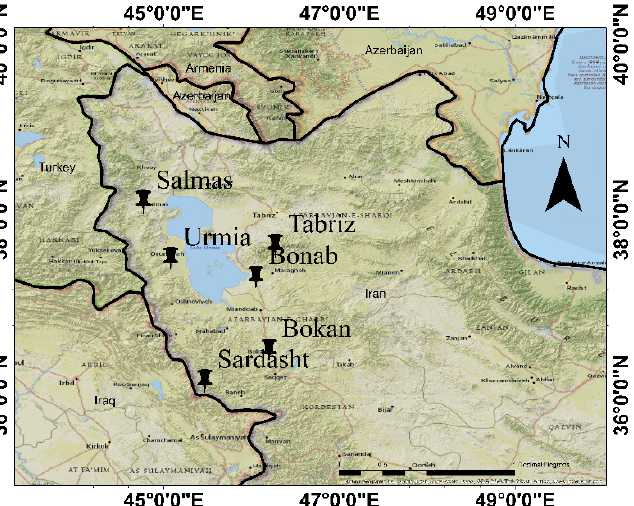
Figure 1. Study area with the six synoptic weather stations and Lake Urmia in NW Iran.